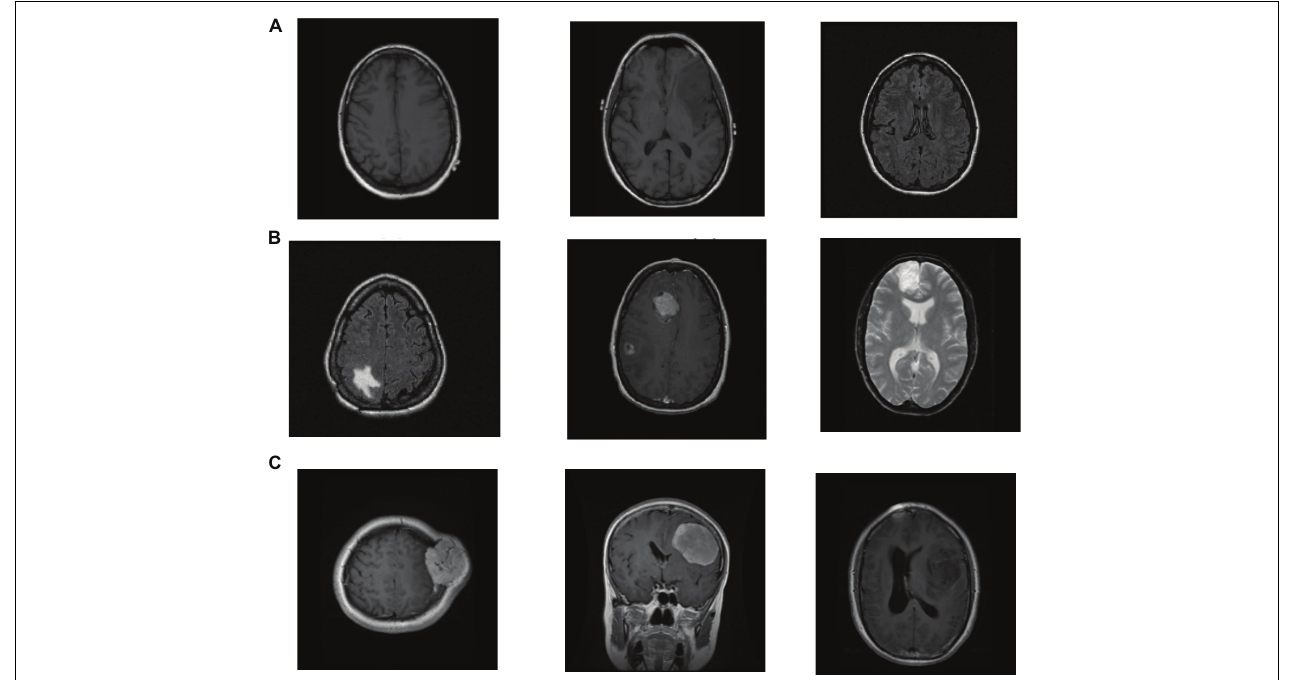
FIGURE 2 | Example samples used in the experiment, (A) normal images in the REMBRANDT dataset, (B) tumor images in the REMBRANDT dataset, (C) tumor images in the Figshare dataset.